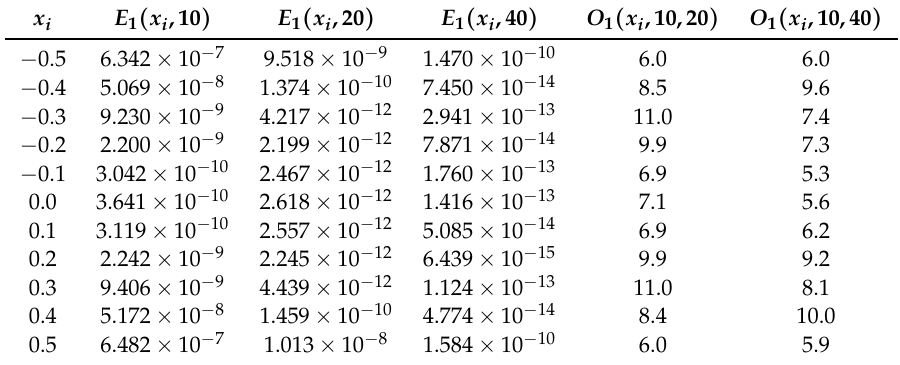
Table 9. The absolute errors of the first order derivatives of y 2 at the knots and the numerical convergence